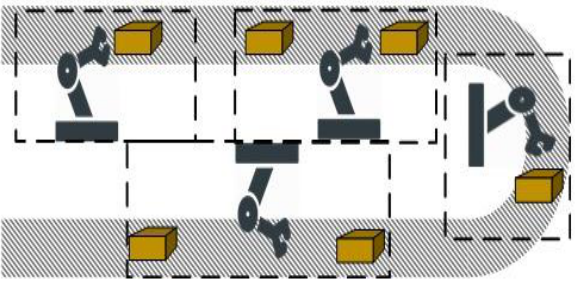
Figure 2. U-shaped robotics assembly line